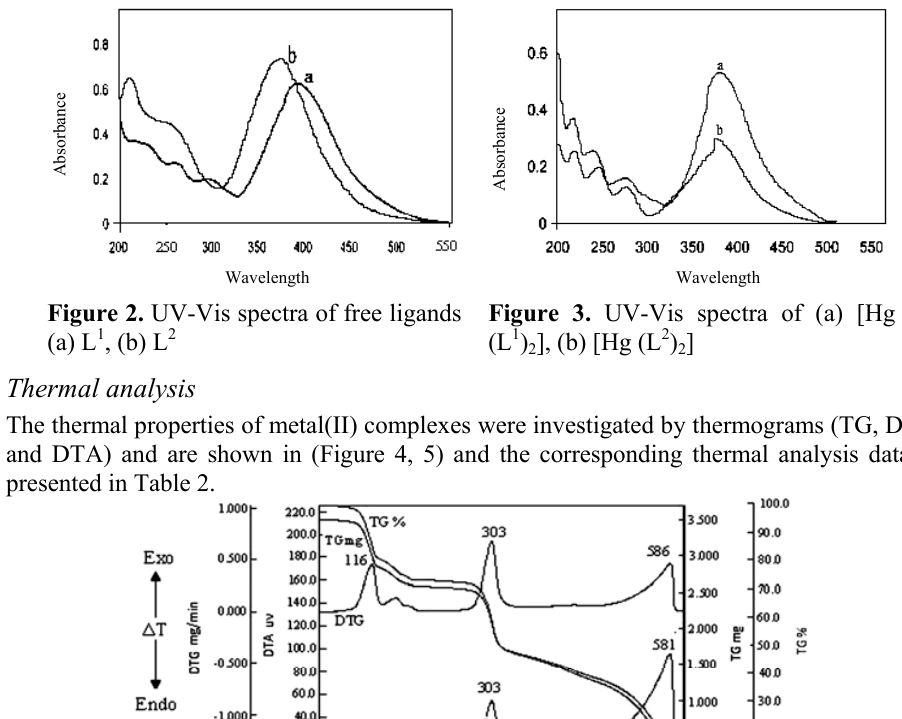
Figure 4. The TG-DTA curves of complex ( 1 )